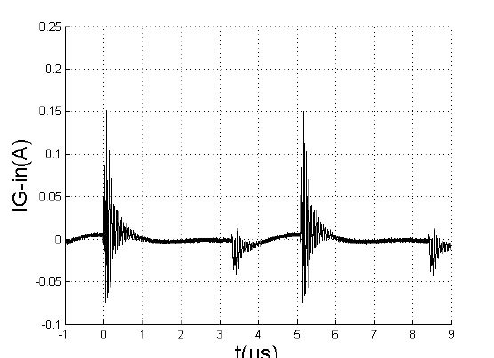
Figure 24: Experimental waveform of the current i